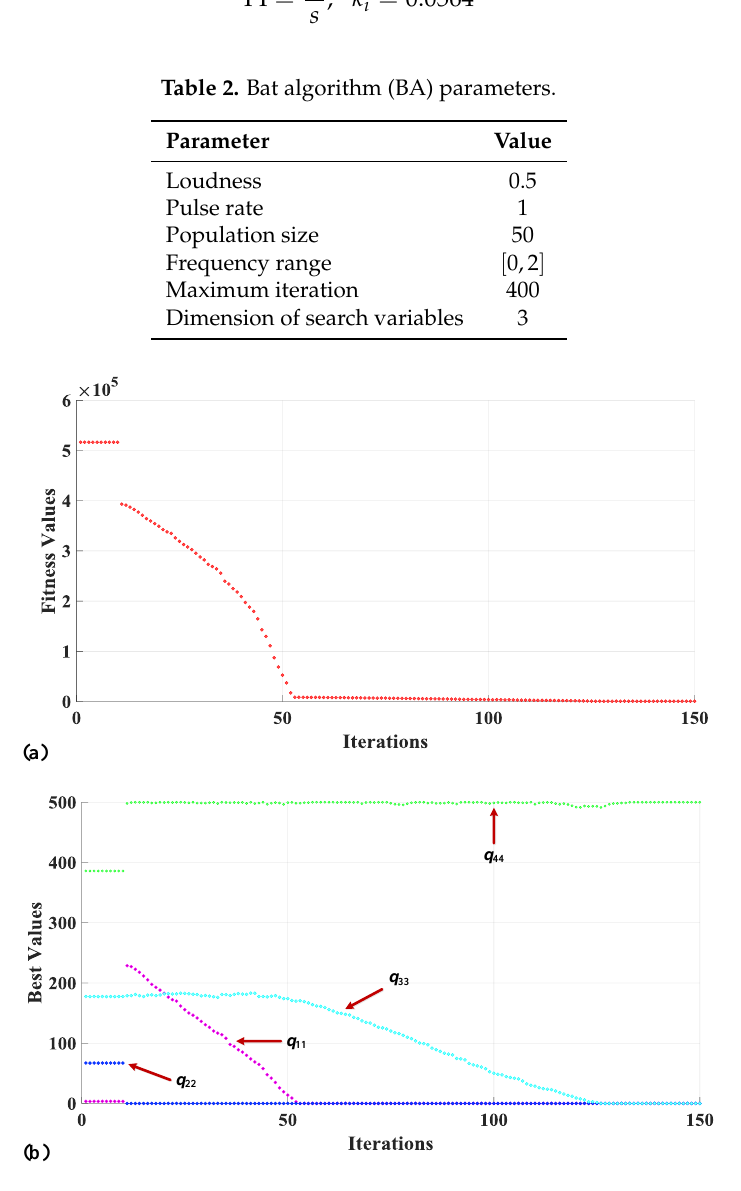
Figure 6. ( a ) Evolution of the fitness function and ( b ) convergence curves of weighting